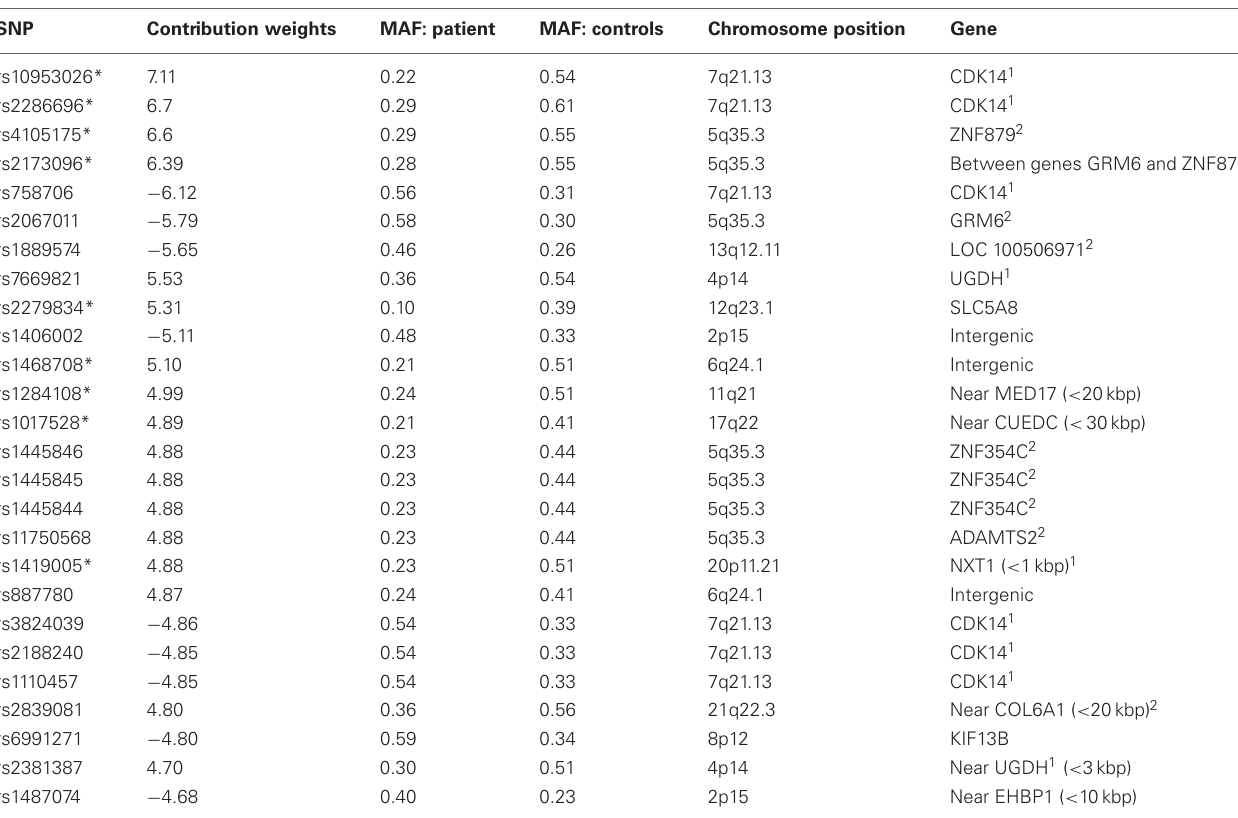
Table 3 | Top component SNPs by weights and associated genes.